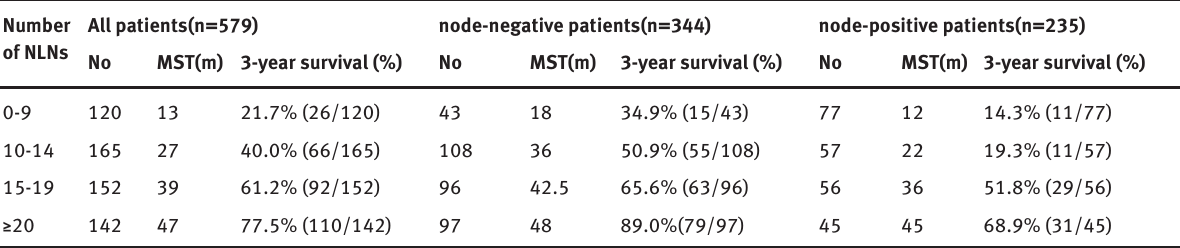
Table 1: The survival characteristics of the node-negative and node-positive